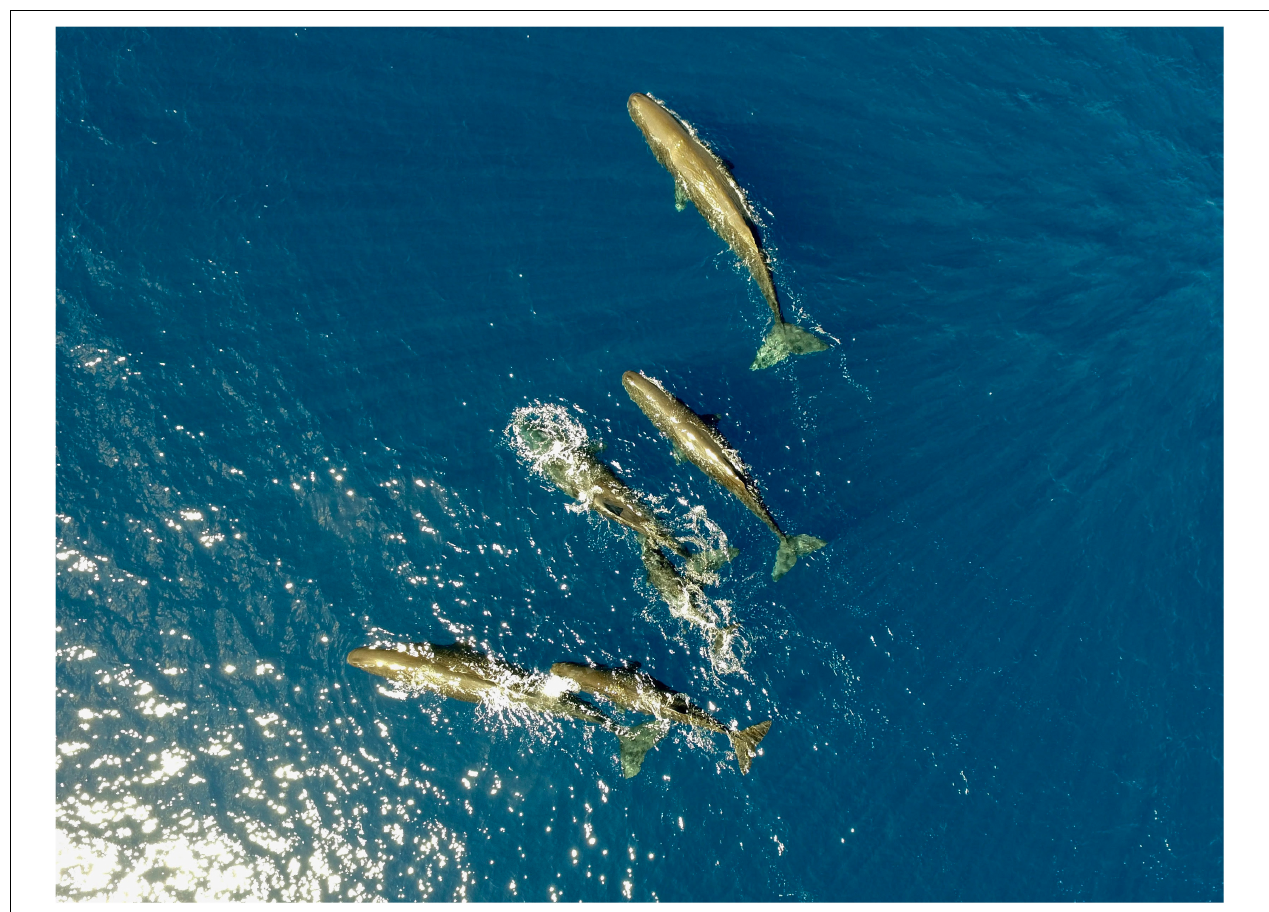
FIGURE 8 | Drone photograph of sperm whales taken inside of PIPA on July 2015 by the SEA vessel SSV